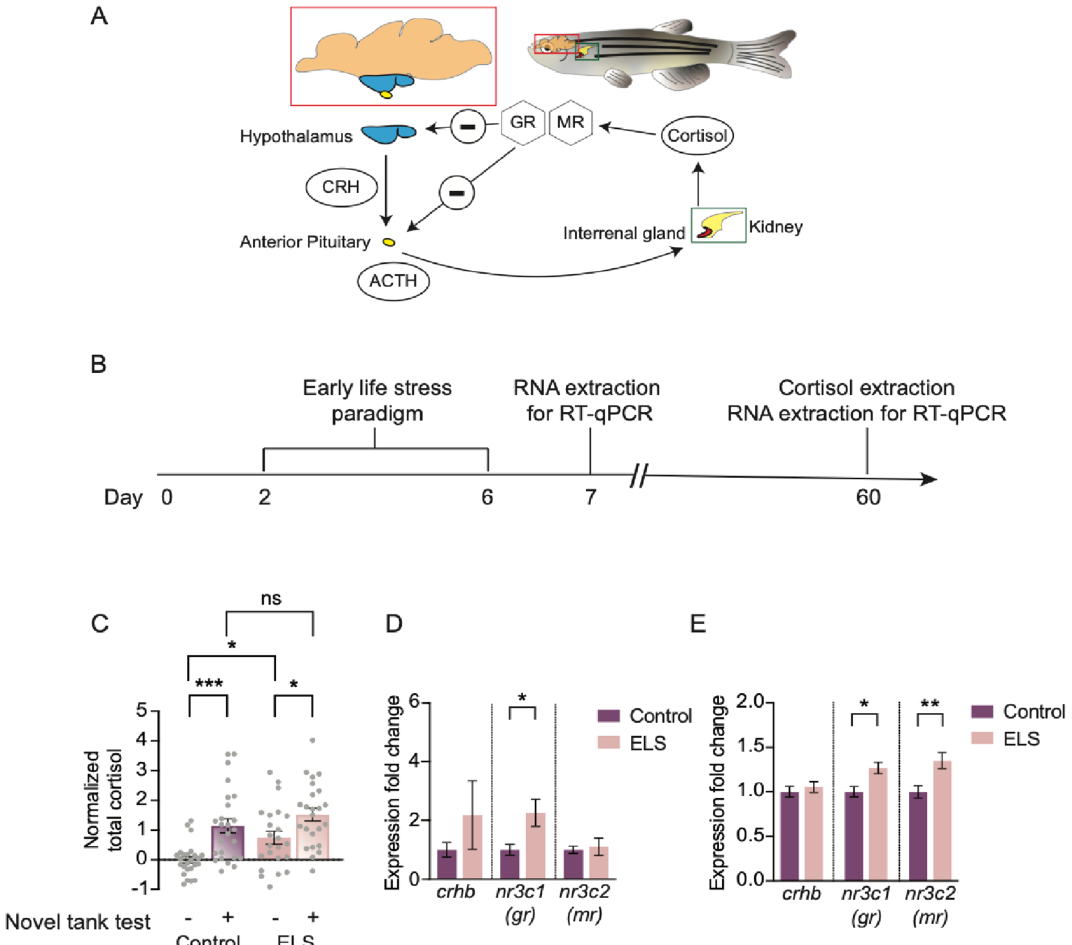
Figure 2. HPI axis is impacted in ELS. ( A ) The HPI axis, the main stress pathway, and its main genes and effectors. Brain of zebrafish is shown in the red bounding box. Within, the hypothalamus (in blue) and the anterior pituitary (in yellow) is shown. During stress, the hypothalamus signals to the anterior pituitary via CRH, and the anterior pituitary signals to the interrenal gland (shaded in red within the head kidney enclosed in the green bounding box) via ACTH. Cortisol is released from the interrenal gland and binds to GR and MR to negatively regulate its release. ( B ) Timeline of ELS and experiments performed. ( C ) Basal cortisol levels (−) were increased in ELS animals (n = 23) compared to controls (n = 25) (One-way ANOVA followed by Sidak’s multiple comparisons post-hoc test, p = 0.044). Elevated cortisol in response to stress (+), after the novel tank test, remain intact in control (n = 25, One-way ANOVA followed by Sidak’s multiple comparisons posthoc test, p = 0.00040) and ELS adults (n = 24, One-way ANOVA followed by Sidak’s multiple comparisons post-hoc test, p = 0.034). Cortisol levels after stress were no different between controls and ELS animals (One-way ANOVA followed by Sidak’s multiple comparisons post-hoc test, p = 0.54). ( D ) Quantitative real-time PCR of 7 dpf control (n = 9) and ELS (n = 8) larvae revealed increased gene expression levels of gr in ELS animals (Unpaired t test, gr: p = 0.018). No significant differences were found in expression levels of crhb and mr (Unpaired t test, crhb: p = 0.31, mr: p = 0.74). ( E ) At 60 dpf, gene expression levels of gr and mr were increased in brains of ELS animals (Unpaired t test, gr: p = 0.0064, mr: p = 0.0023), and no difference in crhb expression levels (Unpaired t test, p = 0.73) were observed, compared to controls. N = 9 per group. Error bars show ± standard error of the mean. Asterisks denote statistical significance (*p = 0.05, **p = 0.005, ***p = 0.0005). ns denotes no